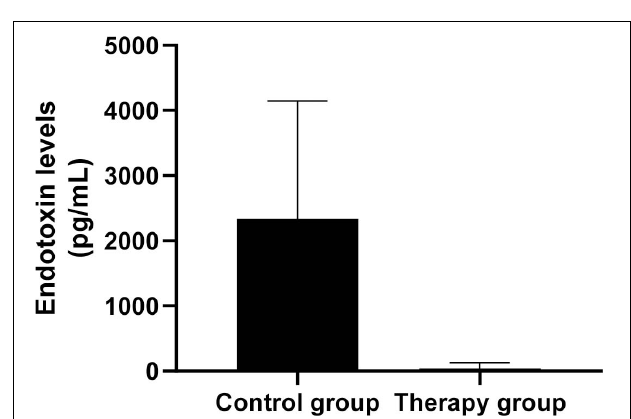
FIGURE 5 | Endotoxin levels in mouse serum. The level of endotoxin in the serum of phage-treated mice ( n = 6) was significantly lower than that of the control mice ( n = 6). Data are presented as mean ± SEM of two experiments (** < 0.01 vs. untreated